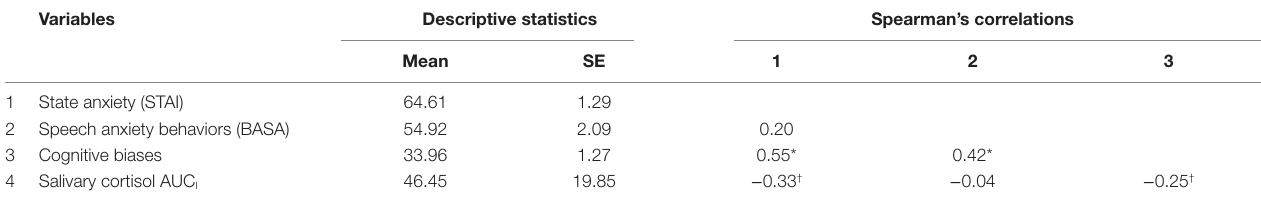
TaBle 4 | relations between state anxiety, speech anxiety behaviors, cognitive biases related to negative evaluation, and salivary cortisol.